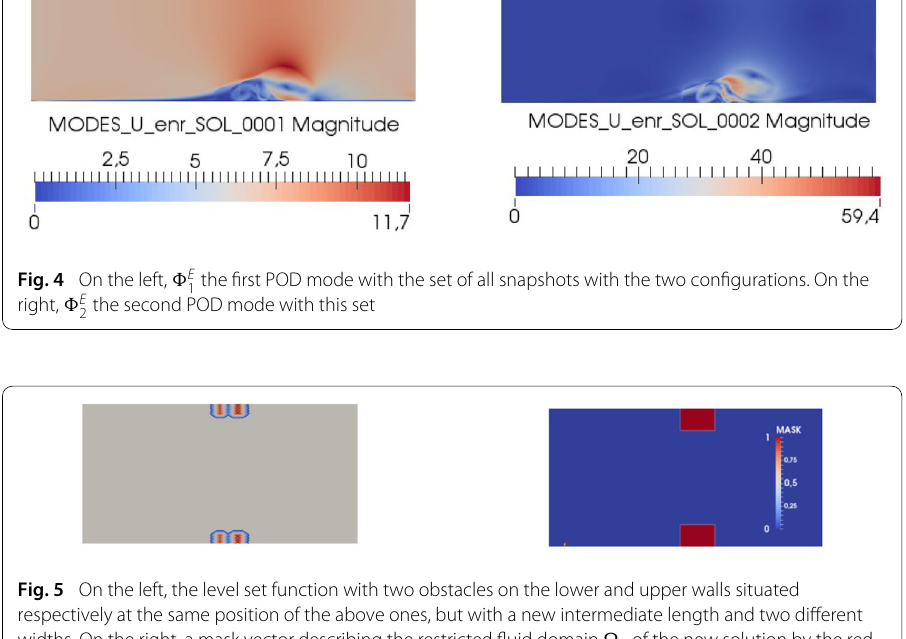
Construction of a reference POD basis and limits of the classical Gappy-POD In this section, we illustrate the limits of the Gappy-POD for our particular